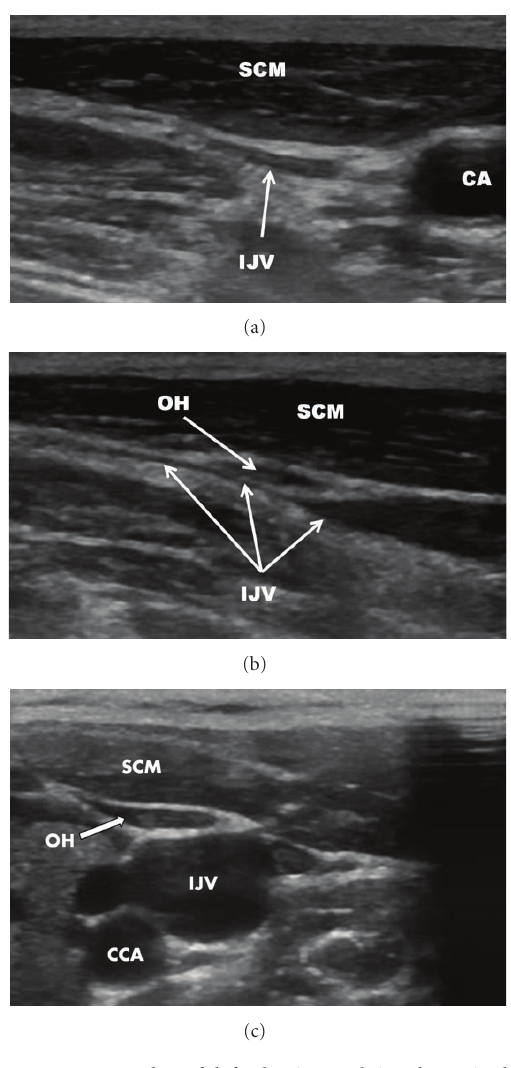
Figure 2: Sonography of left the internal jugular vein before the surgical procedure, mouth closed. (a) transverse imaging; (b) longitudinal imaging; (c) normal anatomical relationships (another patient) omohyoid muscle is adjacent to the internal jugular vein but is not compressing it. IJV: internal jugular vein, CA: carotid artery, SCM: sternocleidomastoid muscle, OH: omohyoid